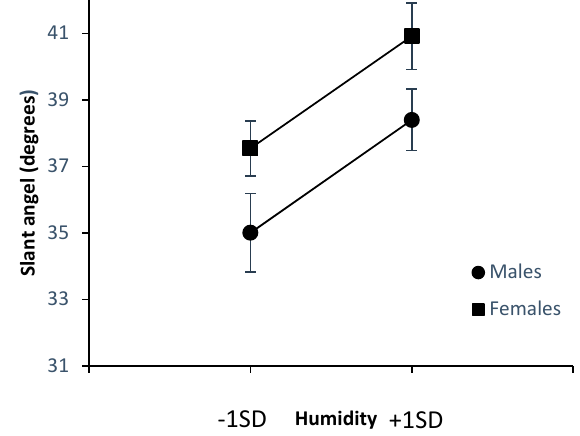
Figure 3. Effects of humidity on estimated slant